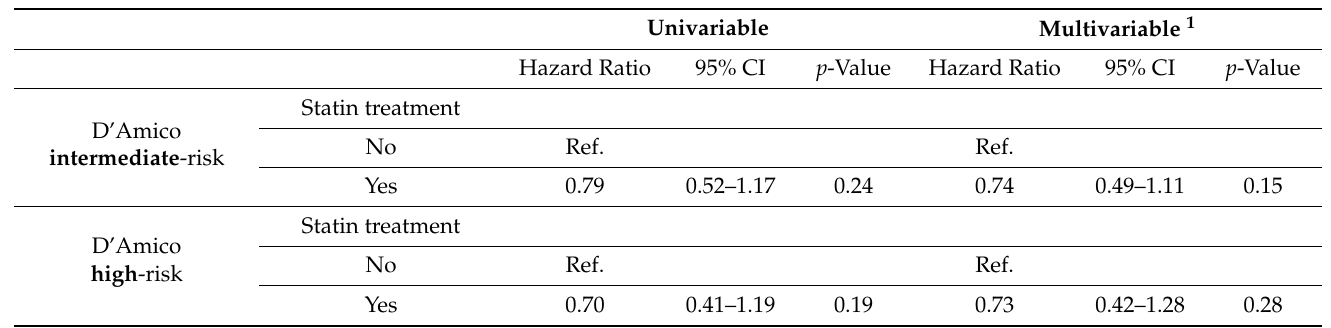
Table 3. Univariable and multivariable Cox regression models predicting biochemical recurrence among EBRT-treated patients (intermediate- and high-risk), according to statin